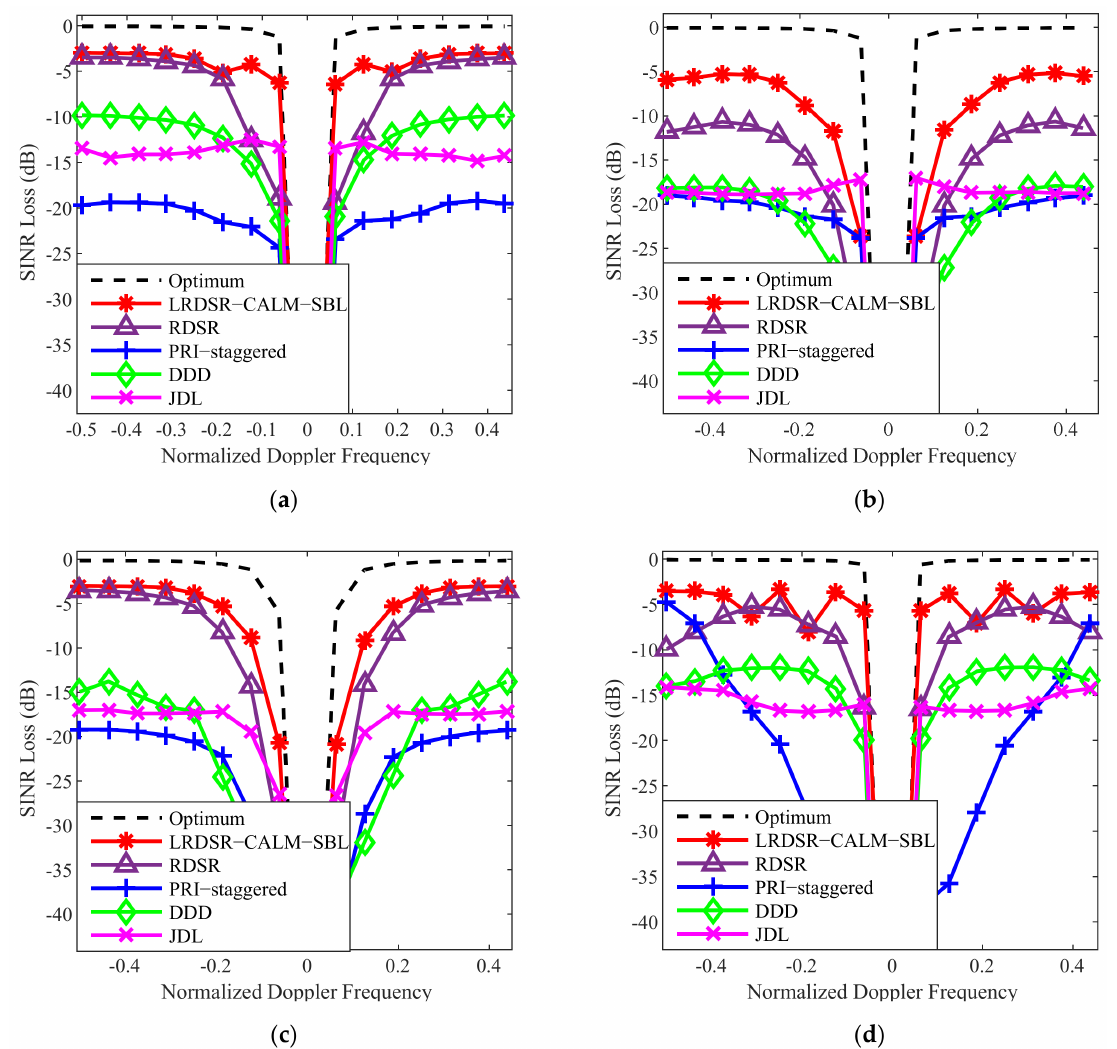
Figure 9. SINR loss comparison of different RD-STAP methods in four different cases. ( a ) Ideal case. ( b ) Spatial mismatch case. ( c ) Temporal mismatch case. ( d ) Ideal case when β =